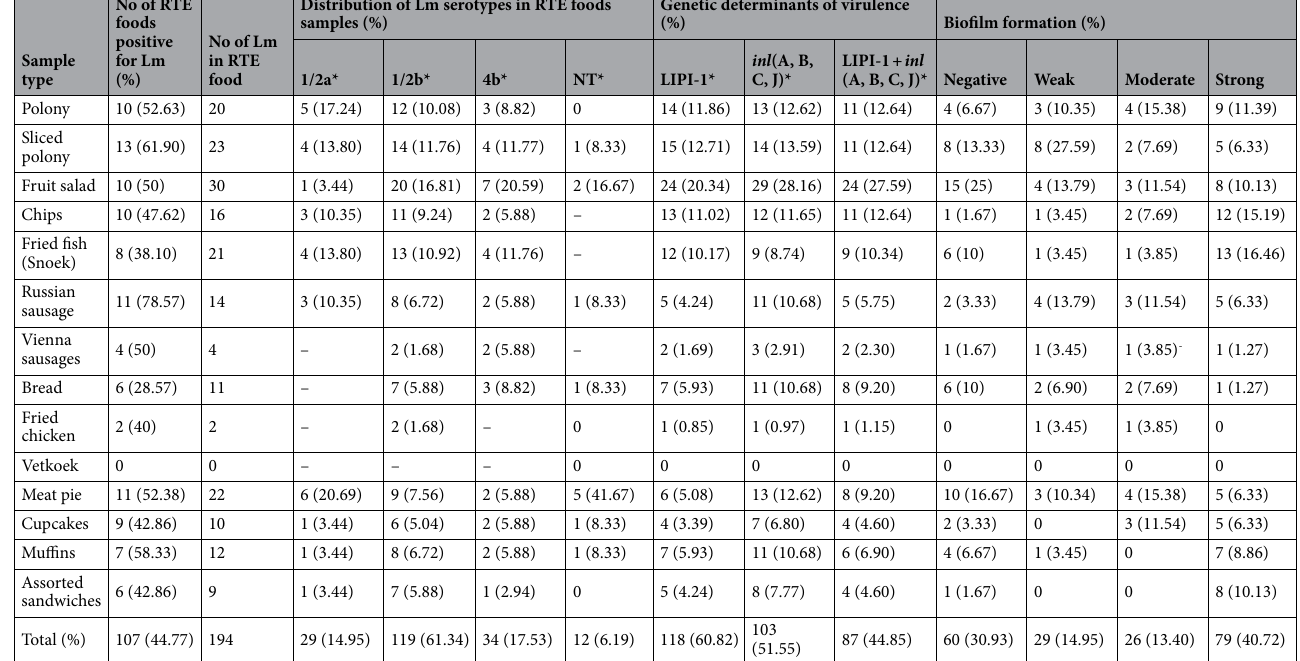
Table 2. Occurrence, serotypes, phenotypic and genotypic determinants of L. monocytogenes virulence recovered from RTE foods. ( * ) distribution of L. monocytogenes serotypes/genetic determinants of virulence in RTE foods is not statistically significant (p > 0.01). (LIPI-1) isolates harbouring all LIPI-1 virulence genes. inl (A, B, C, J) isolates harbouring all the internalin genes. LIPI-1 + inl (A, B, C, J) isolates that harbour all the LIPI and the internalin genes. (NT) Not